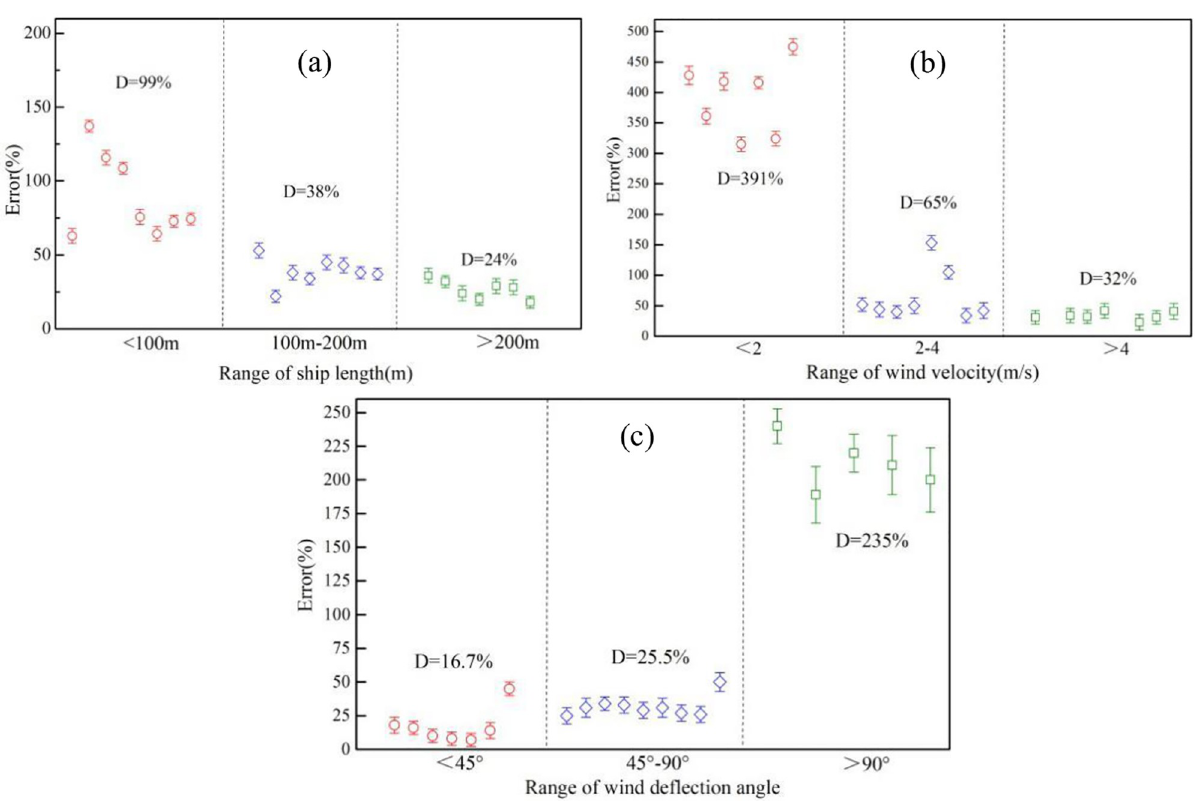
Fig 9. Influence of (a) ship size, (b) wind velocity and (c) wind deflection angle on the accuracy of model.